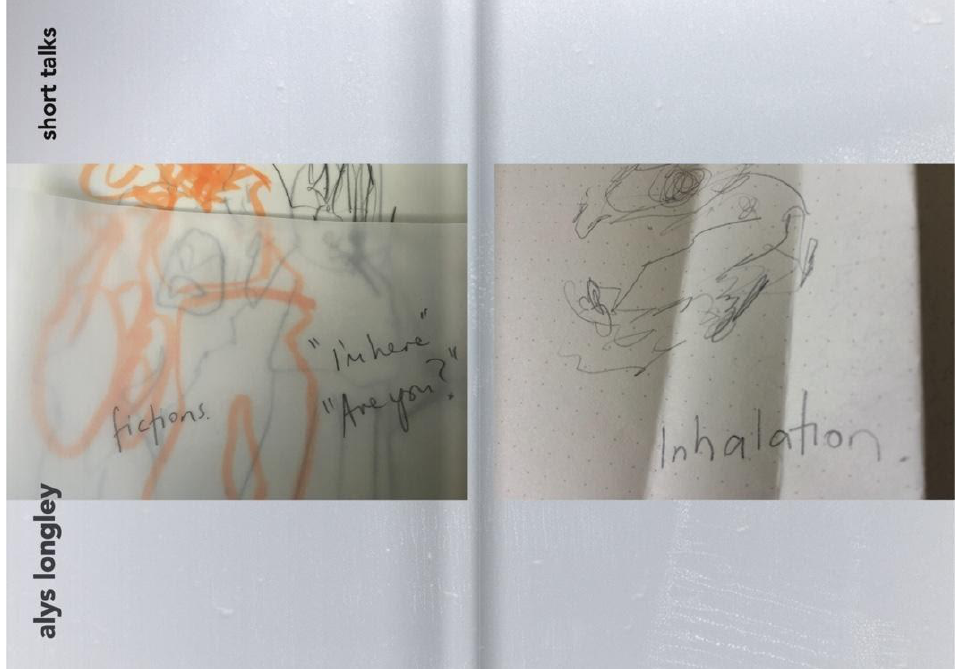
Figure 3: “fictions. ‘I’m here’. ‘Are you?’” Alys Longley Language is an Intangible Bridge artist book